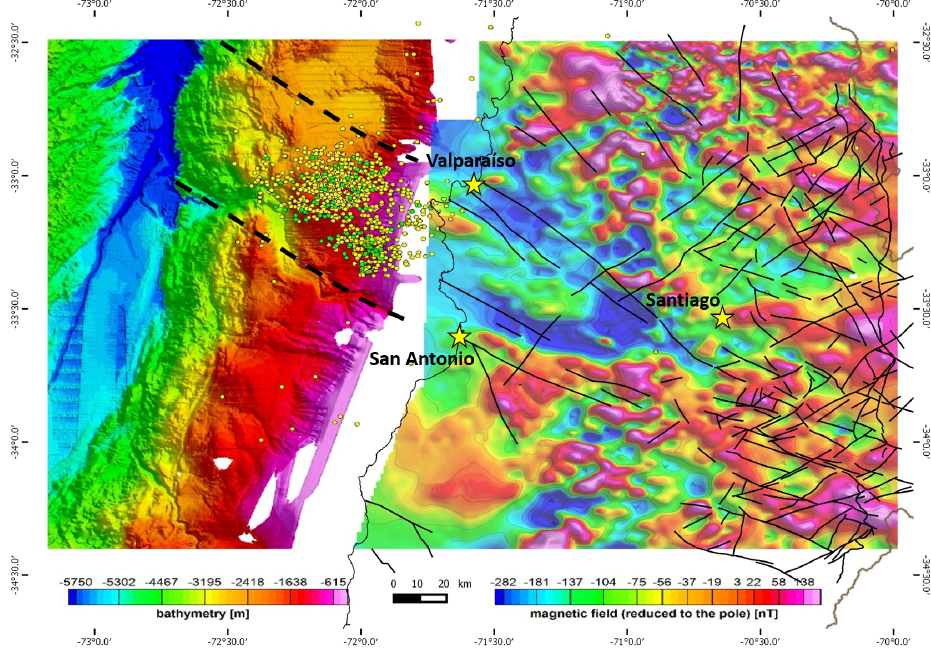
Figure 17. Geophysical expressions of the PFS, the Maipo deformation zone and the Teniente–San Antonio fault system. The sub-marine continental shelf is coloured according to its bathymetry (Weinrebe and Hasert, 2012); thick dashed lines represent the possible submarine prolongation of the two main branches of the MDZ. Colours in the continent correspond to the reduced-to-the-Pole (RTP) aeromagnetic map (SERNAGEOMIN, 1980). The small yellow and green circles show the locations of earthquake hypocentres related to the 2017 Valparaíso sequence (the yellow data set was extracted from Centro Sismológico Nacional (CSN) data repository; the green data set contains relocated events from the Nealy et al., 2017 data repository). The Chile–Argentina international boundary, the coastline and fault architecture from Fig. 16 are also